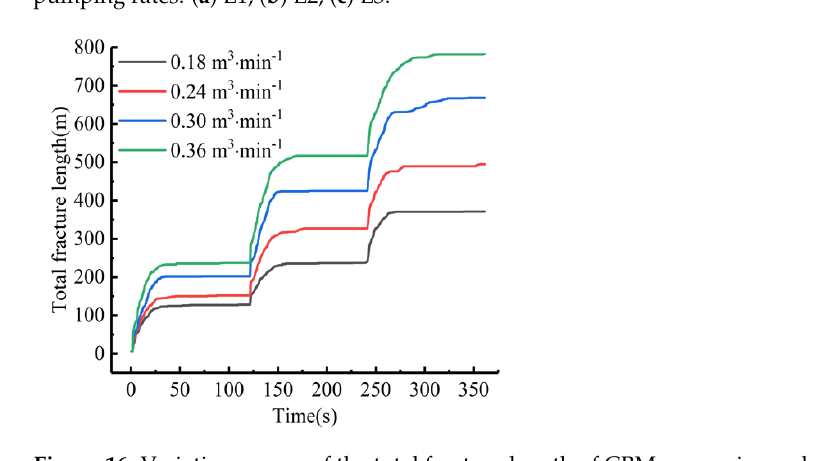
Figure 16. Variation curves of the total fracture length of CBM reservoirs under various fracturing fluid pumping rates.